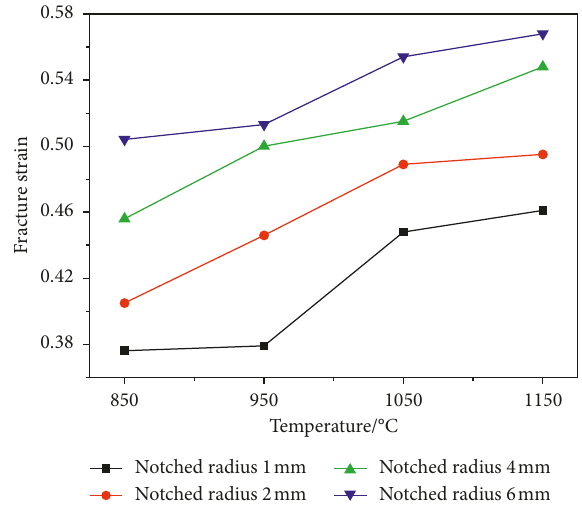
Figure 10: The fracture strain of the sample at different temper- atures and notched radius is obtained, when the deformation rate is 0.5